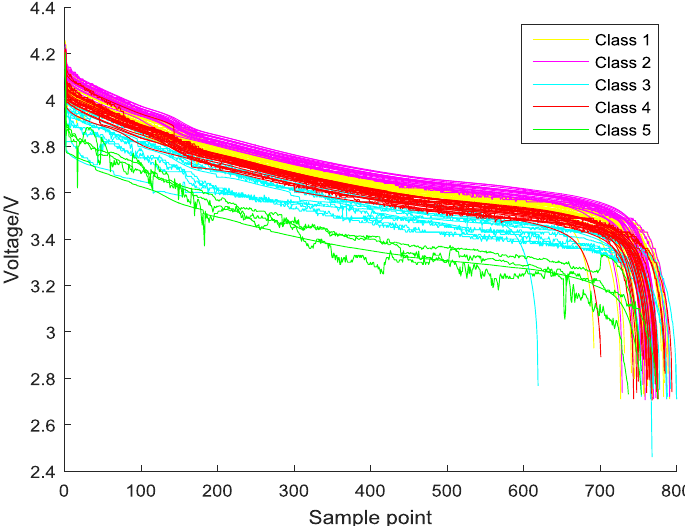
Figure 9. Clustering result for discharge curves with the proposed method.